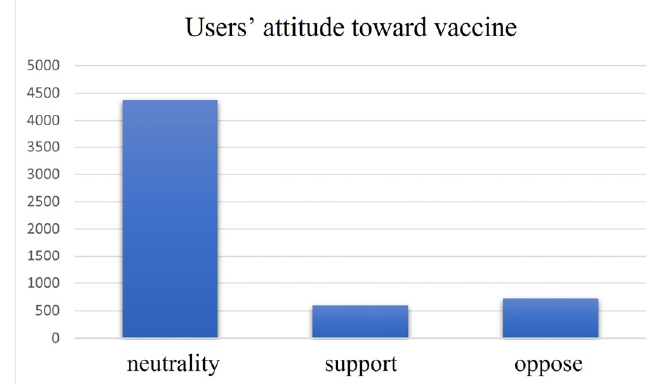
Figure 2. Distribution of users’ vaccine attitudes.